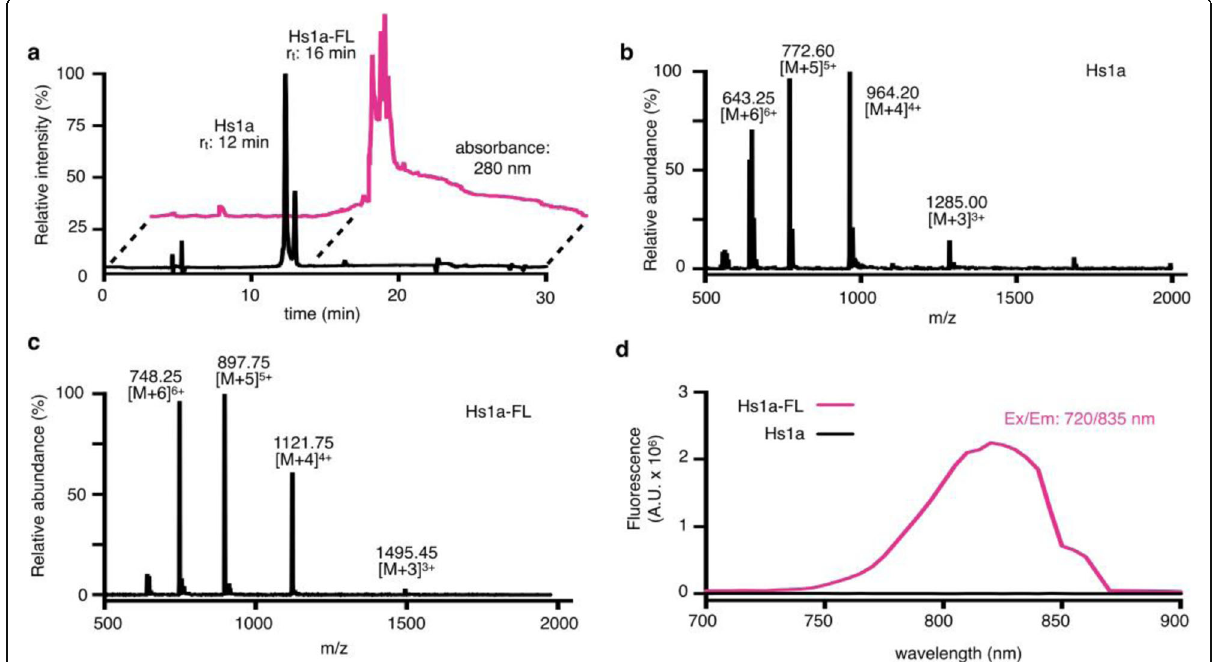
Fig. 2 Chemical characterization of Hs1a-FL. a RP-HPLC chromatograms of Hs1a (black) and Hs1a-FL (pink) with absorbances observed at 280 nm. b LC-MS spectrum of Hs1a and c of Hs1a-FL. The mass spectra show four major ion species that correspond to the calculated mass of Hs1a peptide and four major ion species that confirm the calculated mass of Hs1a-FL after dye conjugation. d Fluorescence spectra (Ex/Em 720/835 nm) of 0.1 μ M Hs1a peptide (black) and 0.1 μ M Hs1a-FL